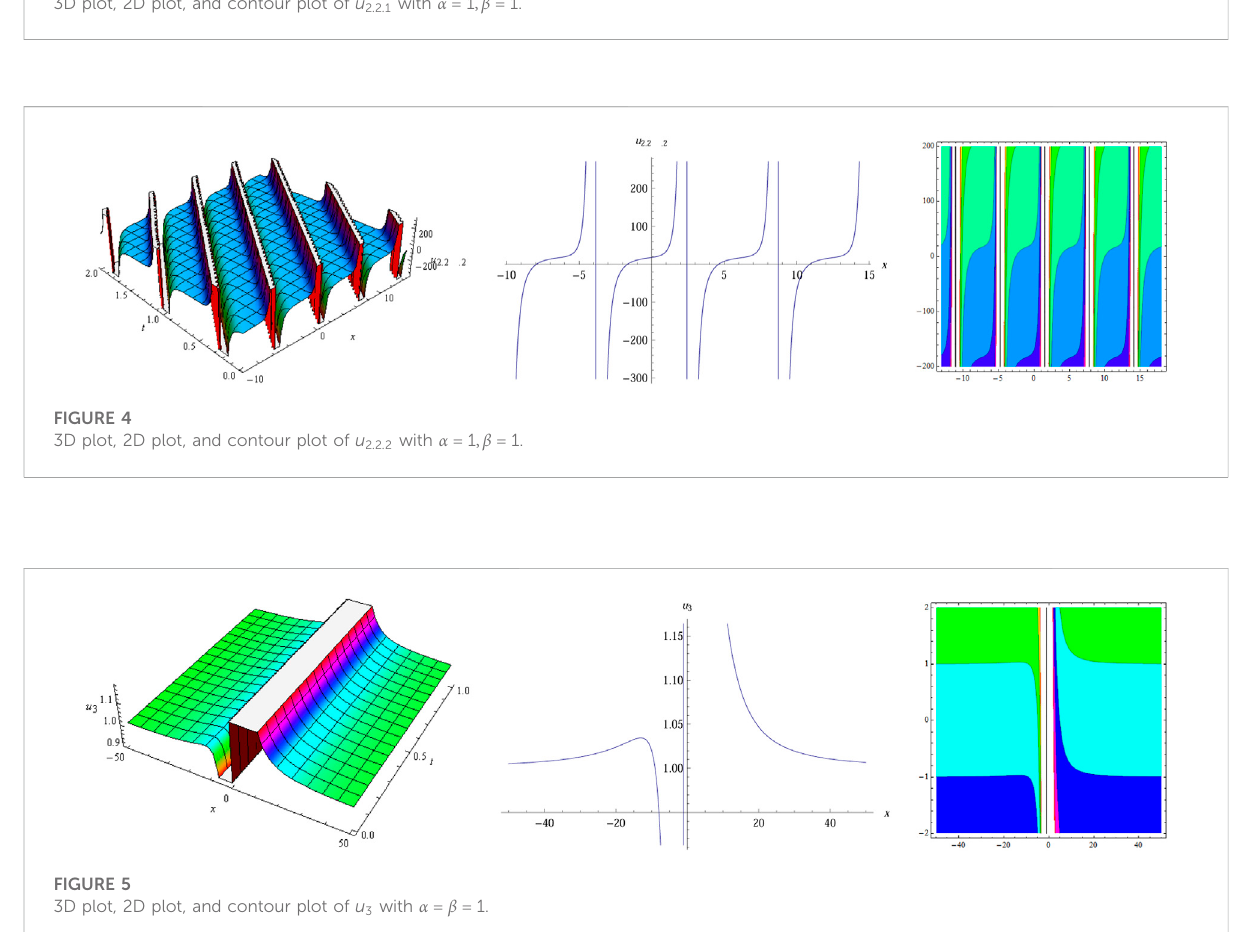
FIGURE 3 3D plot, 2D plot, and contour plot of u 2 . 2 . 1 with α (cid:2) 1 , β (cid:2) 1.